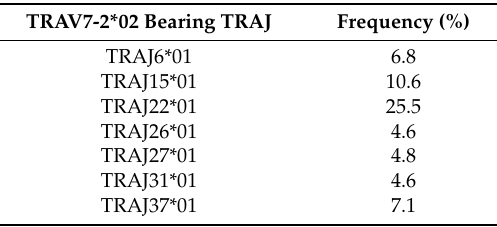
Table 1. Frequency of TRAJ repertoires bearing TRAV7-2*02.